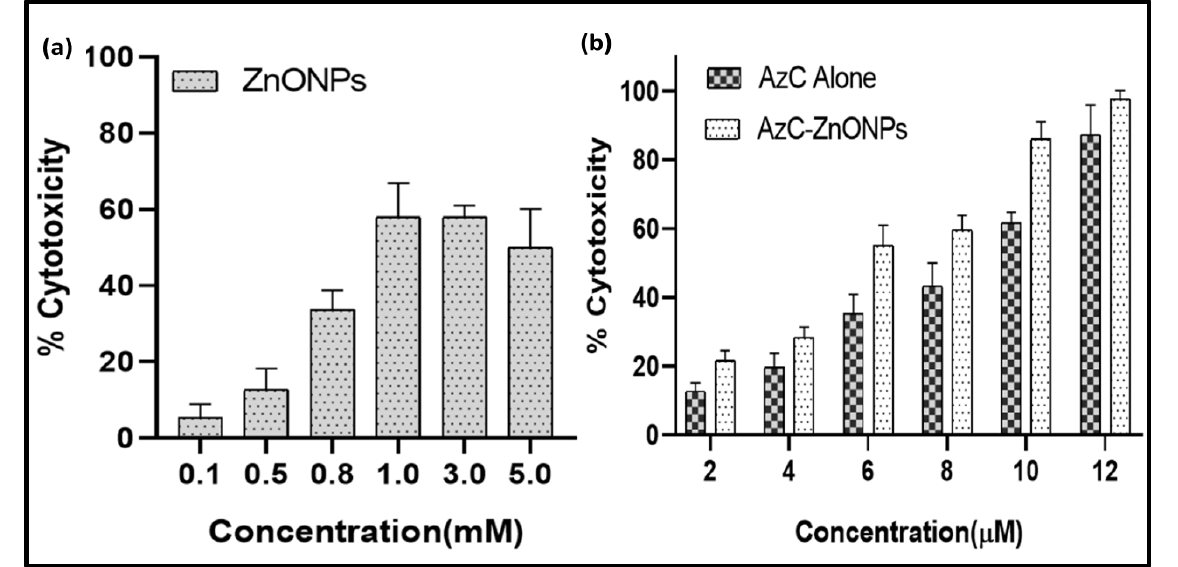
Figure 8. Cytotoxicity study of A ‐ 549 cell treated with different concentrations of ( a ) ZnONPs; ( b ) AzC alone and AzC ‐ ZnONPs ( n = 4).